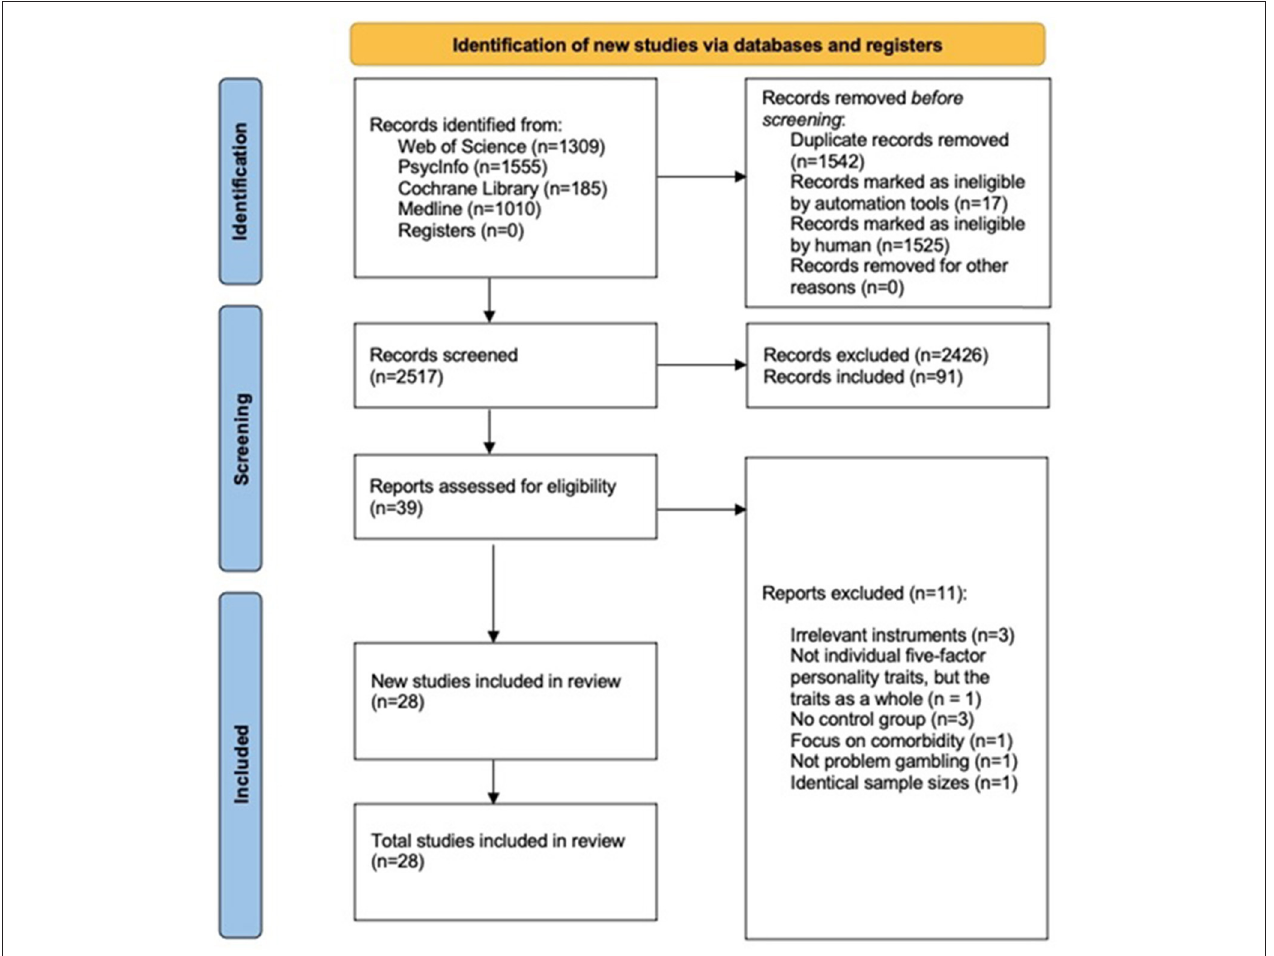
FIGURE 1 | Flow chart depicting the search and inclusion